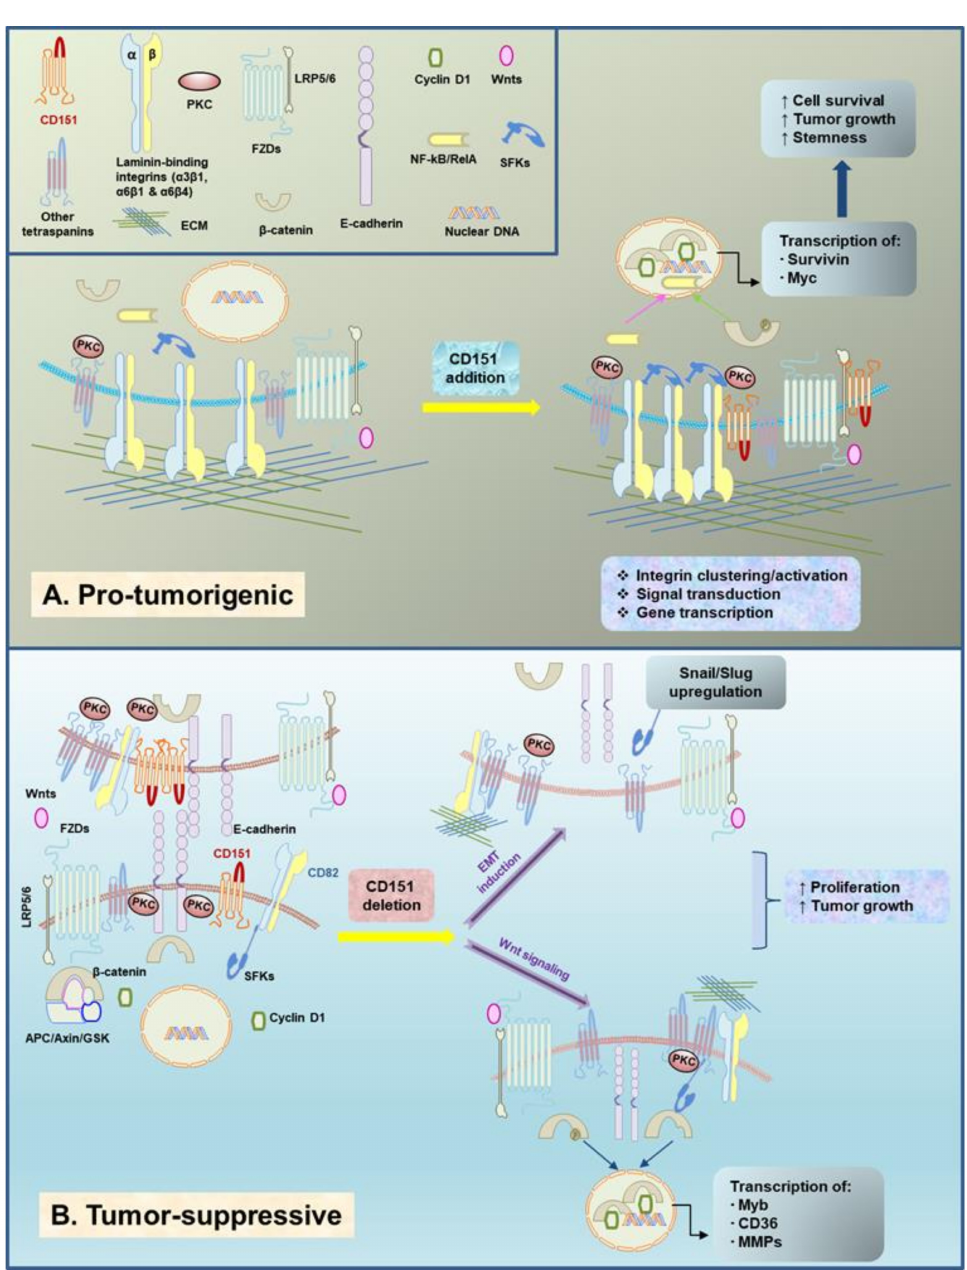
Figure 2. Emerging evidence on the context-dependent crosstalk between tetraspanin CD151 and the Wnt signaling pathway in breast cancer. ( A ) Hypothetical molecular basis for the cooperative role of CD151/laminin-binding integrin complexes and the Wnt/ pathway in basal cell-origin breast cancer. ( B ) A working model for CD151-mediated suppression of the Wnt/ β -catenin signaling, and associated changes in transcription factors Snail and Slug, cell-cell adhesion and EMT in luminal epithelial cell-origin breast